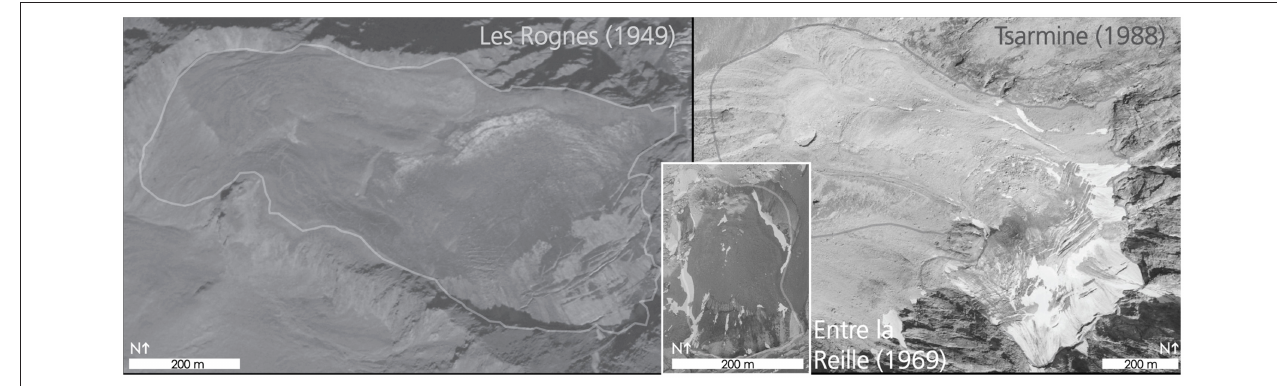
FIGURE 3 | Aerial images of the study sites. The Rognes picture was taken on 04/09/1949 ( © IGN; n ◦ IGNF_PVA_1-0__1949-09-04__C3630-0121_1949_F3630-3631_0045, available at geoportail.gouv.fr). The Entre la Reille picture (white inset) was taken on